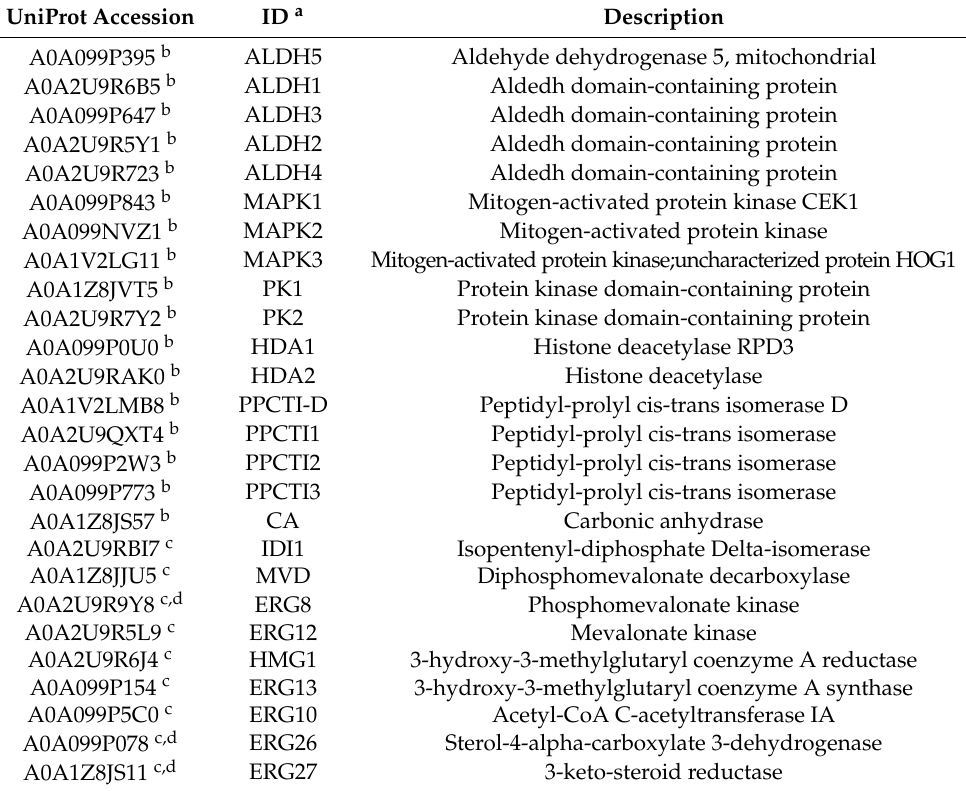
Table 3. List of the 37 potential targets of compound 16 in C. krusei